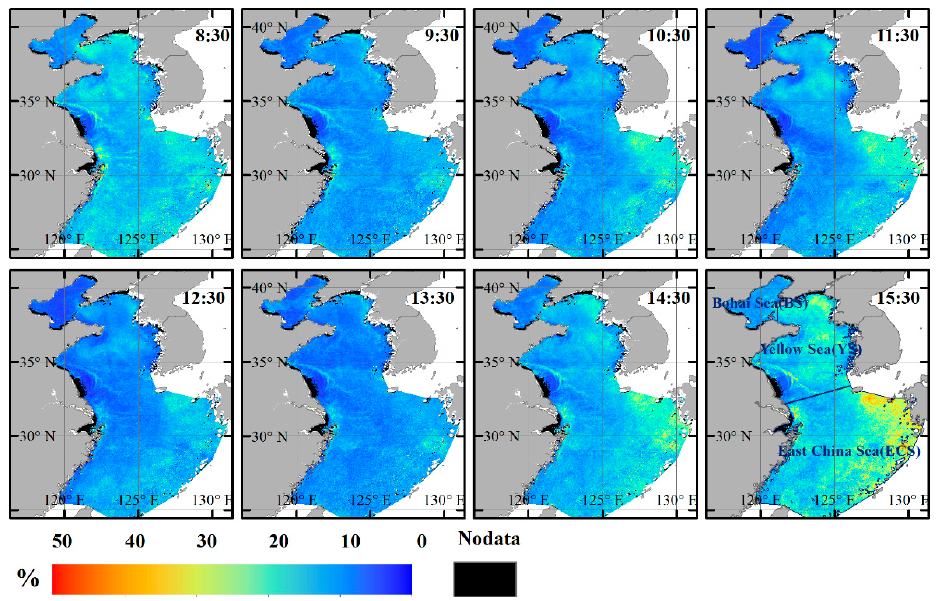
Figure 4. Hourly TSS bias in Chinese seas from GOCI observations from 2013 to 2017.